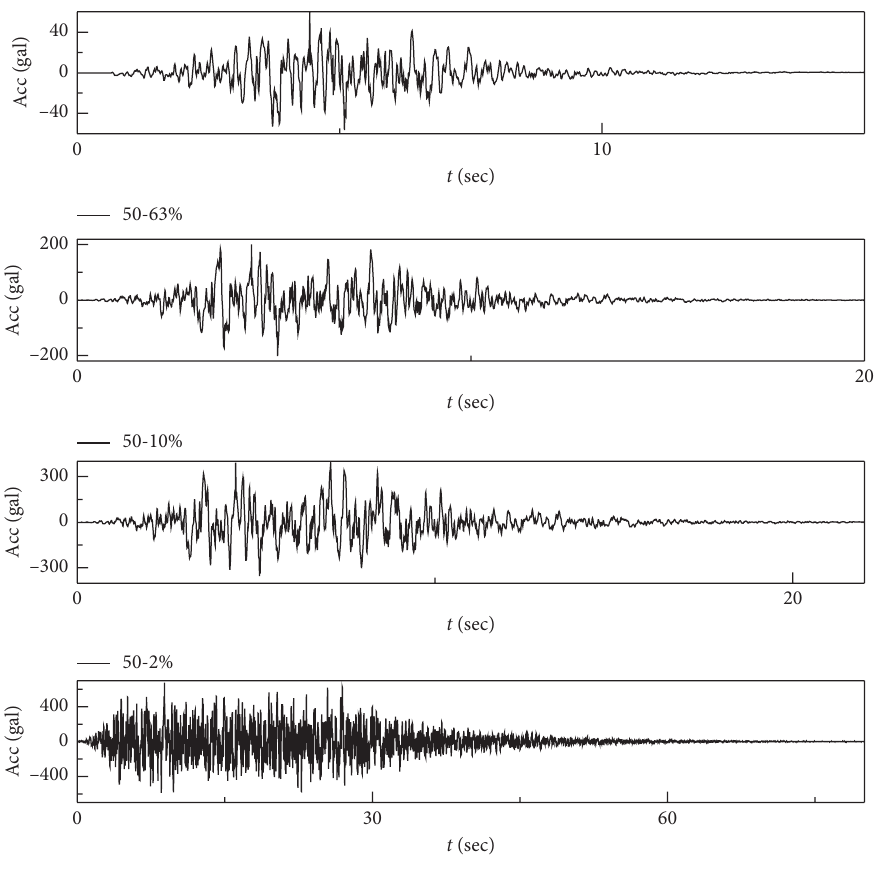
Figure 2: Ground motions under different